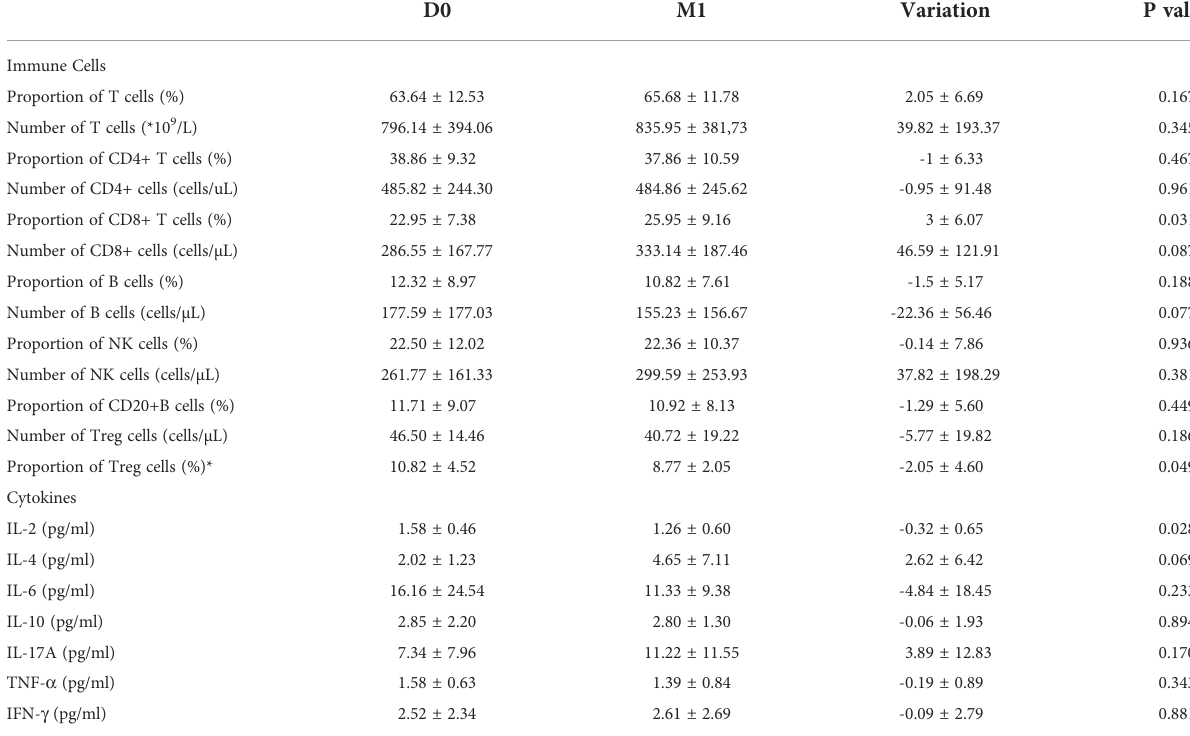
TABLE 2 Variations in immune cell subsets and cytokines after MWA. D0